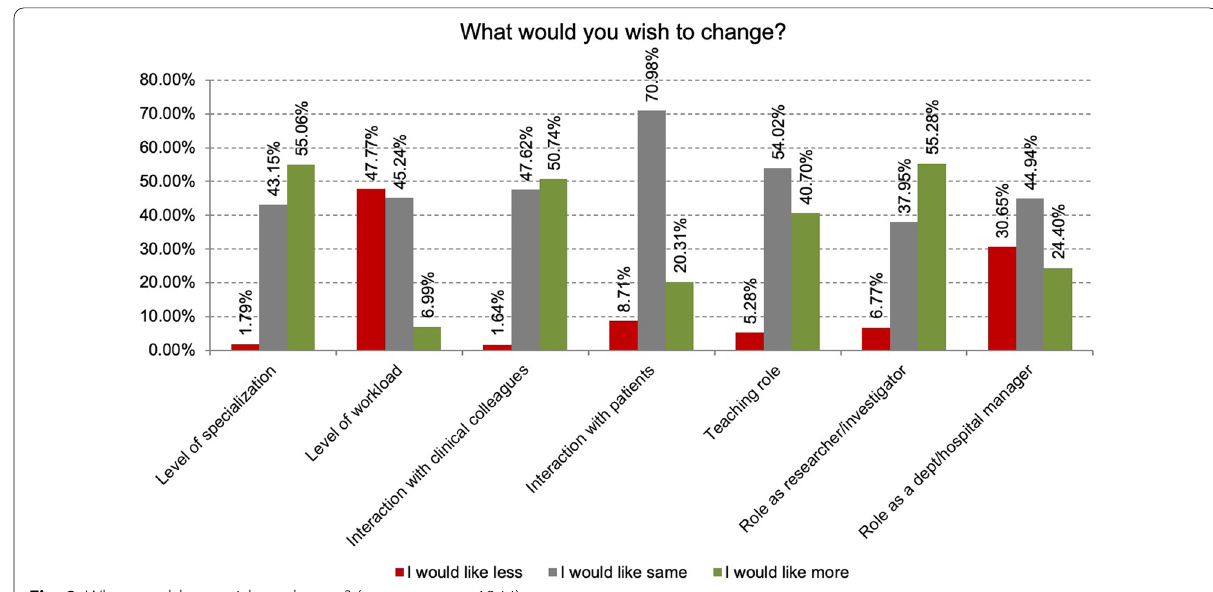
Fig. 8 What would you wish to change? (responses n